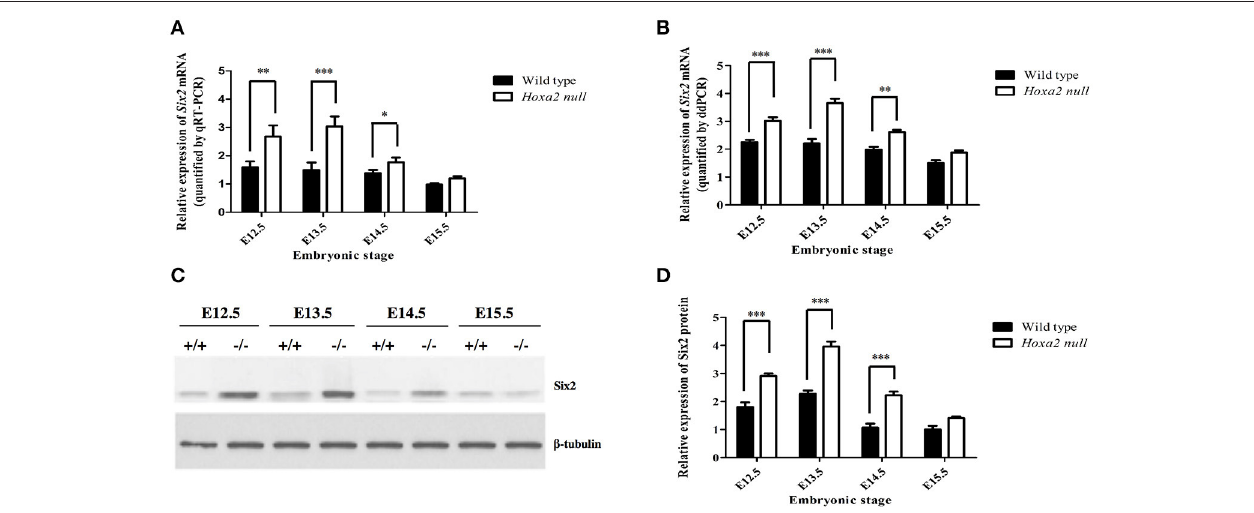
( Figure 1A ). The palatal shelves of Hoxa2 − / − null embryos showed a significant upregulation of Six2 mRNA levels relative to wild-type palates at stages E12.5 to E14.5 ( Figure 1A